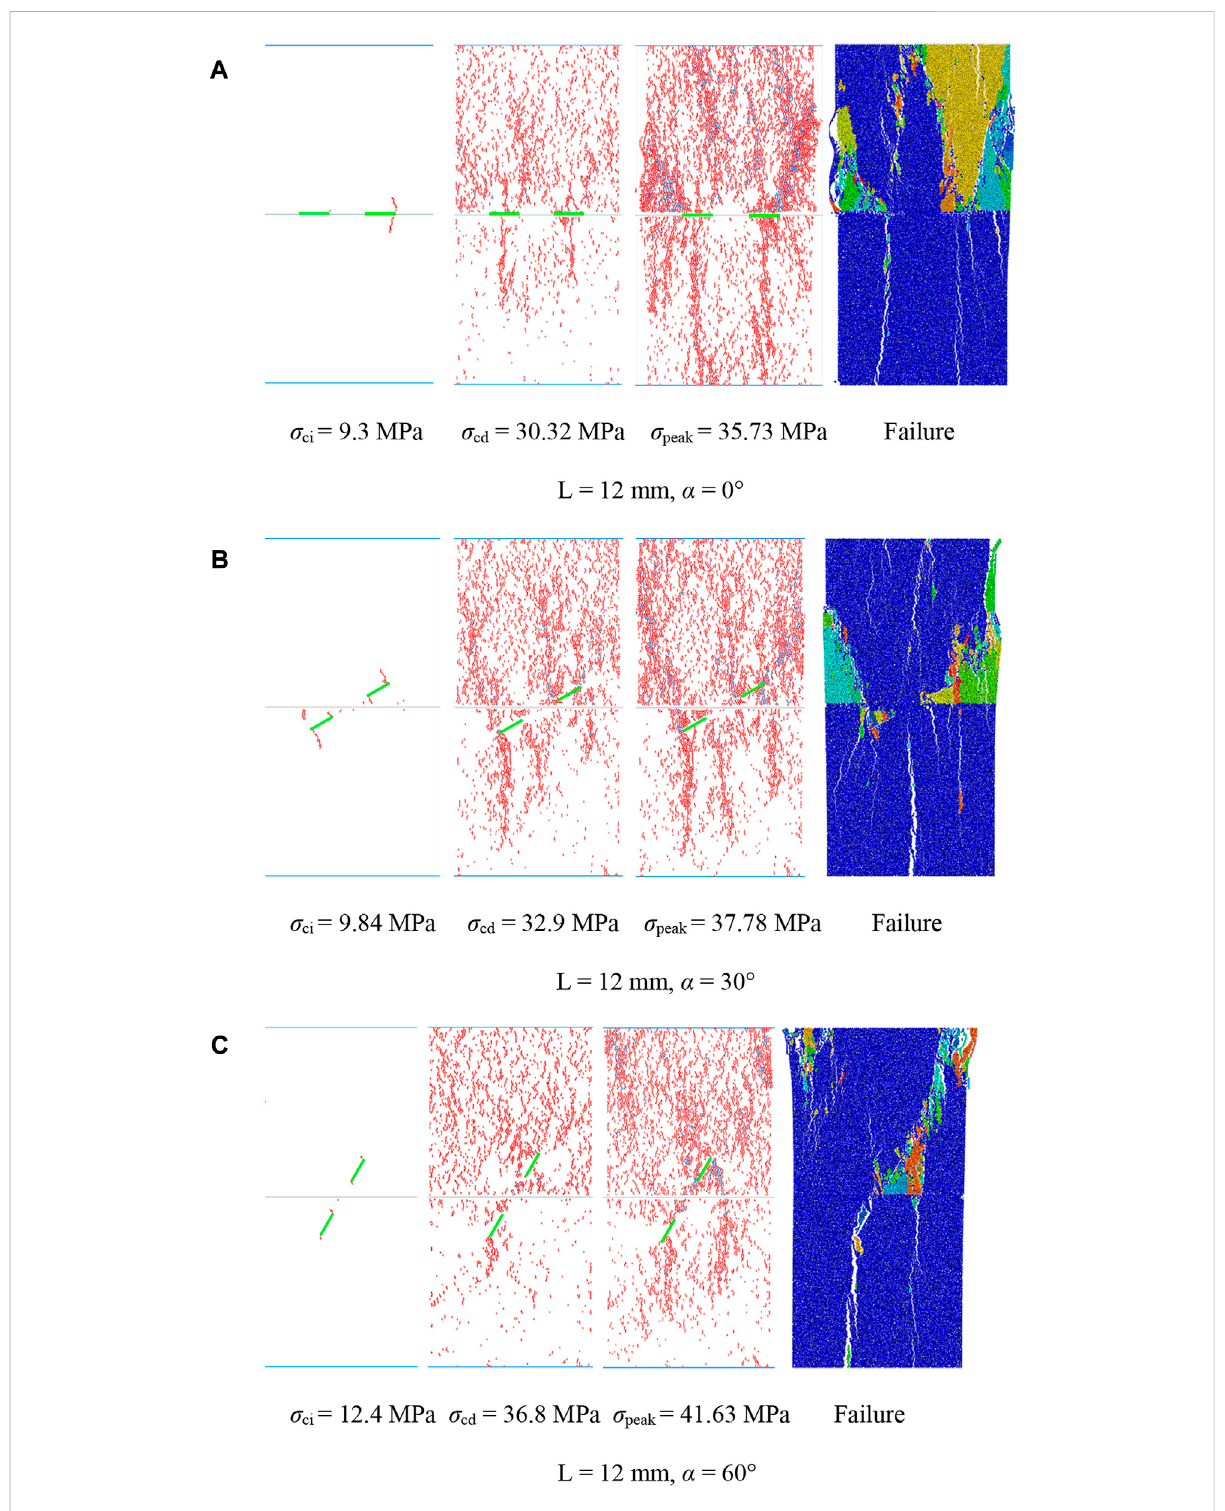
FIGURE 14 Microcrack propagation process of rock samples at different fracture inclination angles when L = 12 mm. (A) L = 12 mm, α = 0 ° , (B) L = 12 mm, α = 30 ° , (C) L = 12 mm, α = 60 °